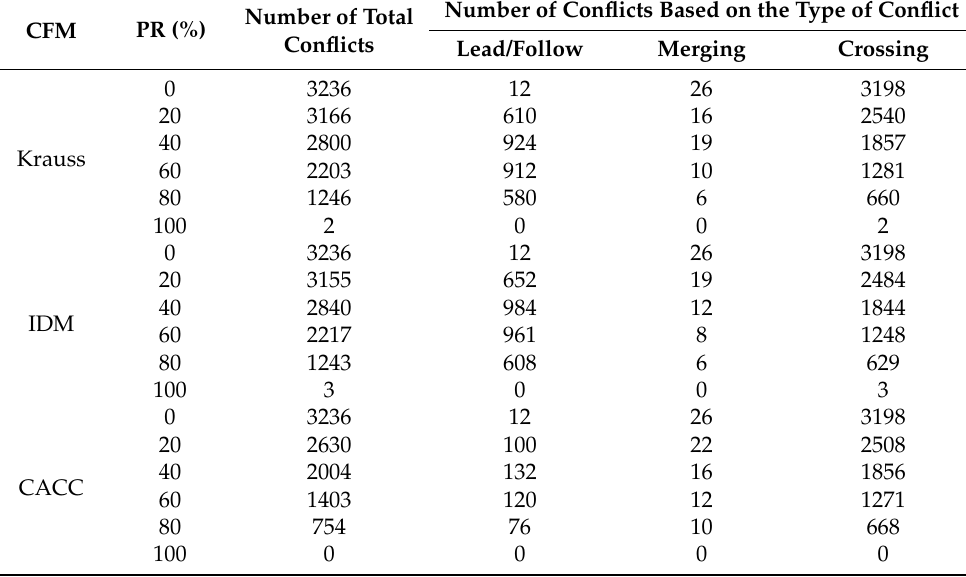
Table A1. Results of impact of CAVs on safety of grid network (CFM = car-following model, PR = penetration rate). Number of Total CFM PR (%)